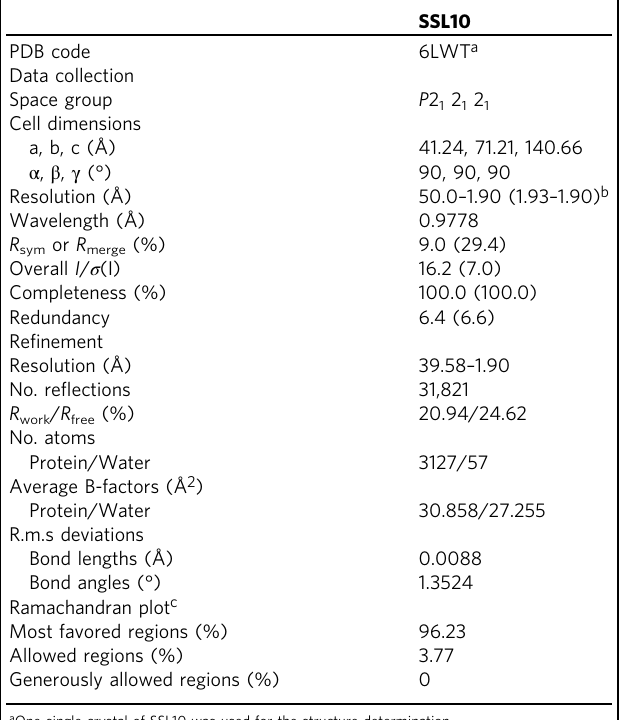
a One single crystal of SSL10 was used for the structure determination. b The values in parentheses refer to the highest resolution shell. c Statistics for the Ramachandran plot from an analysis using